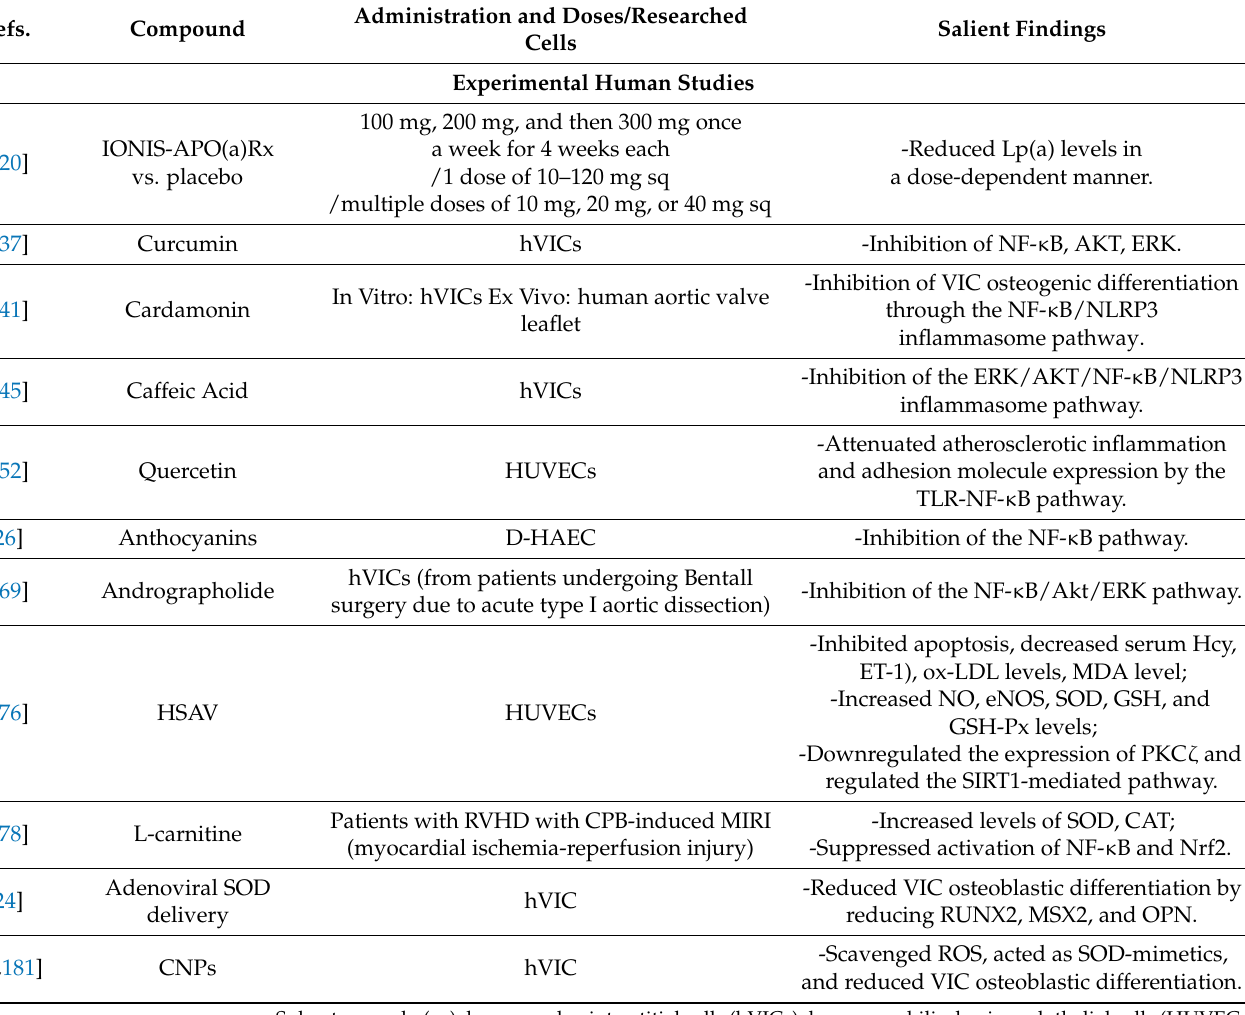
Table 2. Human experimental research of therapeutic strategies via OS in CAVD. Refs.